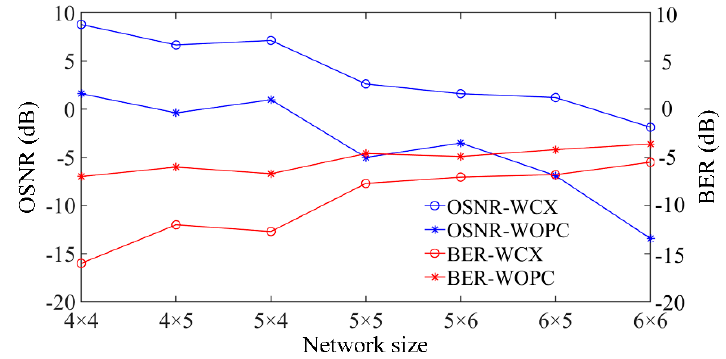
Figure 11. OSNR and BER comparison under di ff erent network sizes.